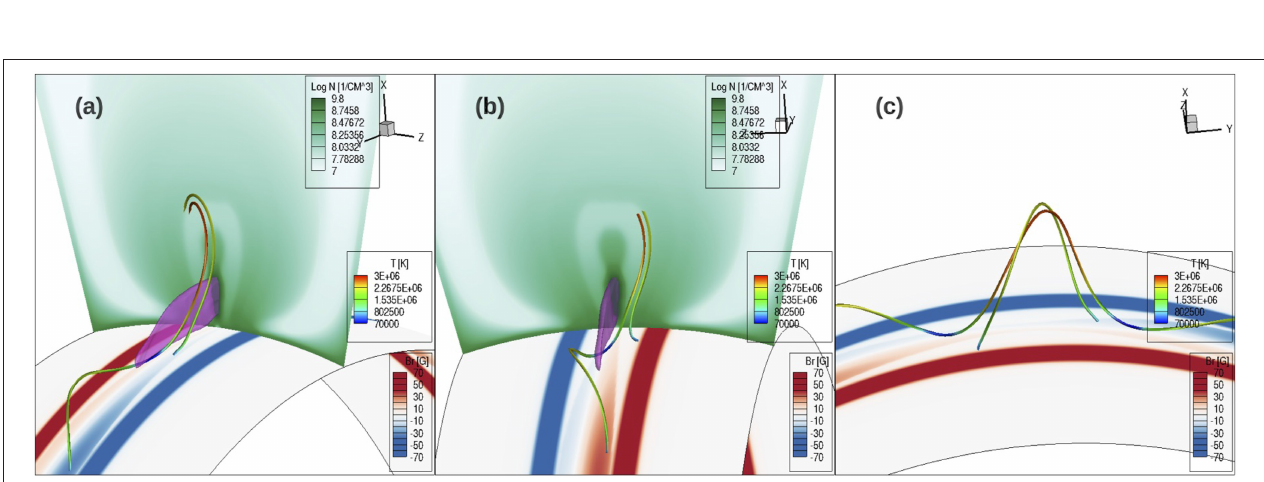
FIGURE 10 | Two field lines traced from two adjacent points on the two sides of the cavity boundary in the density cross-section shown in (a,b) viewed from two different perspectives from opposite sides of the cross-section. The pink iso-surface of temperature at T = 7.5 × 10 4 K outlines the prominence condensations. (c) shows the same field lines from a different view without the density cross-section and the iso-surface for the prominence. The lower boundary shows the normal magnetic field distribution B r .